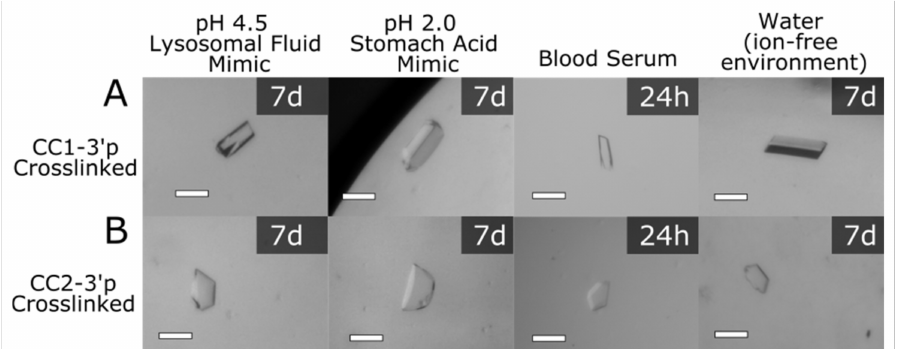
Figure 6. A survey of crosslinked crystals (15 mg/mL EDC 20 h) with terminal 3 (cid:48) phosphates in four stringent solutions. ( A ) CC1-3 (cid:48) p crosslinked crystals incubated in pH 4.5, pH 2.0 and water for seven days and blood serum for twenty-four hours. ( B ) CC2-3 (cid:48) p crosslinked crystals incubated in pH 4.5, pH 2.0 and water for seven days and blood serum for twenty-four